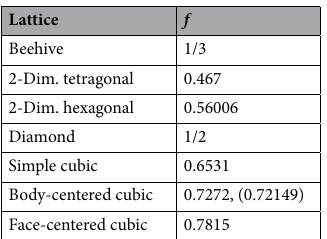
Table 2. Correlation factors f , obtained analytically for simple lattice model systems 20